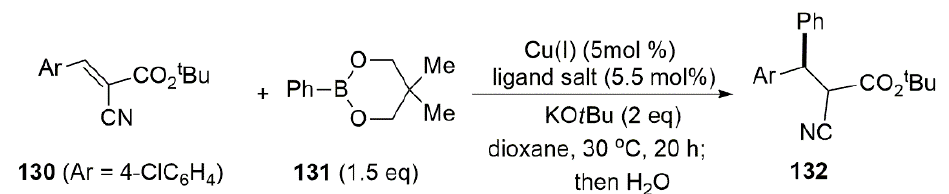
Figure 11. Chiral mono ‐ and bidentate NHC ligands [156].